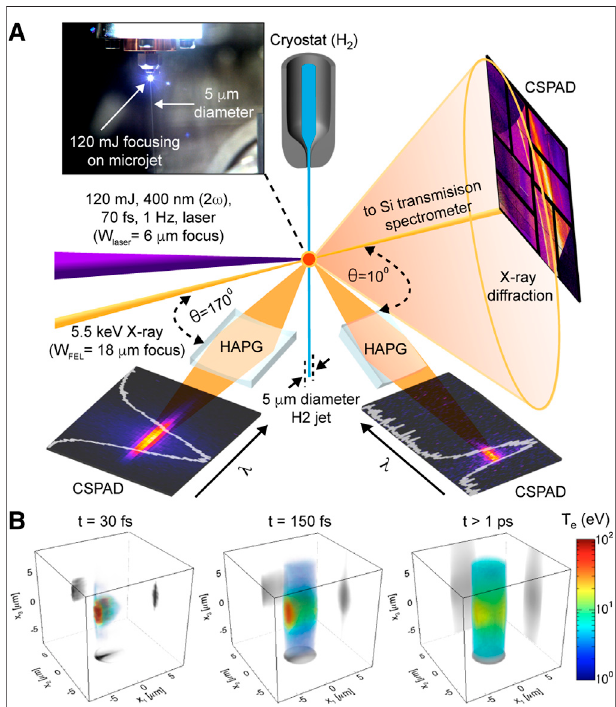
FIGURE 1 | (color online) (A) Ultrafast pump-probe schematic of experimentalsetupshowingtheLCLSX-raybeamscatteringin1 Hzrepetition from a fs-irradiated 5 μ mH 2 diameterjet. Thescattered photonsarecaptured on a Cornell SLAC Pixel Array Detectors (CSPADs) to angularly resolve the static structure factor as well as measure the changes to the lattice structureoverpstimesteps.Thedataoverlaidonthebackward,k=4.8nm − 1 , crystal spectrometer resolves inelastic scattered X-rays. The data overlaid on the forward, k = 52 nm − 1 , spectrometer resolves elastically and inelastically scattered X-rays. (B) 3D OSIRIS simulations showing time evolution of electron heating induced by the fs-laser; The laser produces a hot electron population with slope temperature of 14.3 keV via J × B heating. At t < 50 fs, the background electrons at the surface are heated to T e ≳ 100 eV. At t = 150 fs, fast electrons then recirculate in the target, heating the background through a combination of collisionless and collisional processes; At t ≳ 1 ps, fast electrons thermalize with the background electrons averaged over the experimental scattering volume, < T e > ~ 10 eV, where subsequent electron- ion relaxation and equilibration